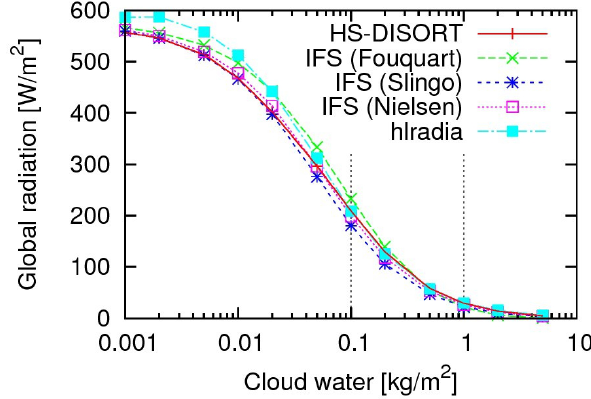
Figure 9. Global radiation as a function of cloud water load (ex- periment 4). The results from HS-DISORT (green dashed curve), IFS Fouquart with SW inhomogeneity factors of 0.7 (magenta dot- ted curve) and 1.0 (red curve), and hlradia with SW inhomogeneity factors of 0.8 (blue dashed curve) and 1.0 (black curve) are shown. Table 3. Absolute differences (unit: Wm − 2 ) for experiment 4. IFS- F refers to the IFS radiation scheme using the Fouquart (1987) liq- uid cloud optical property parameterisation. The numbers 0.7, 0.8 and 1.0 give the value of the cloud SW inhomogeneity factors. Cl. wat.